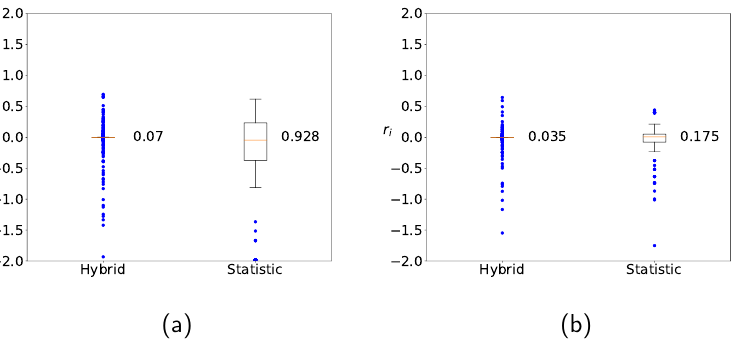
Figure 10. Distribution of predicted values for Zener diodes with the hybrid method ( a ) without clustering and ( b ) with